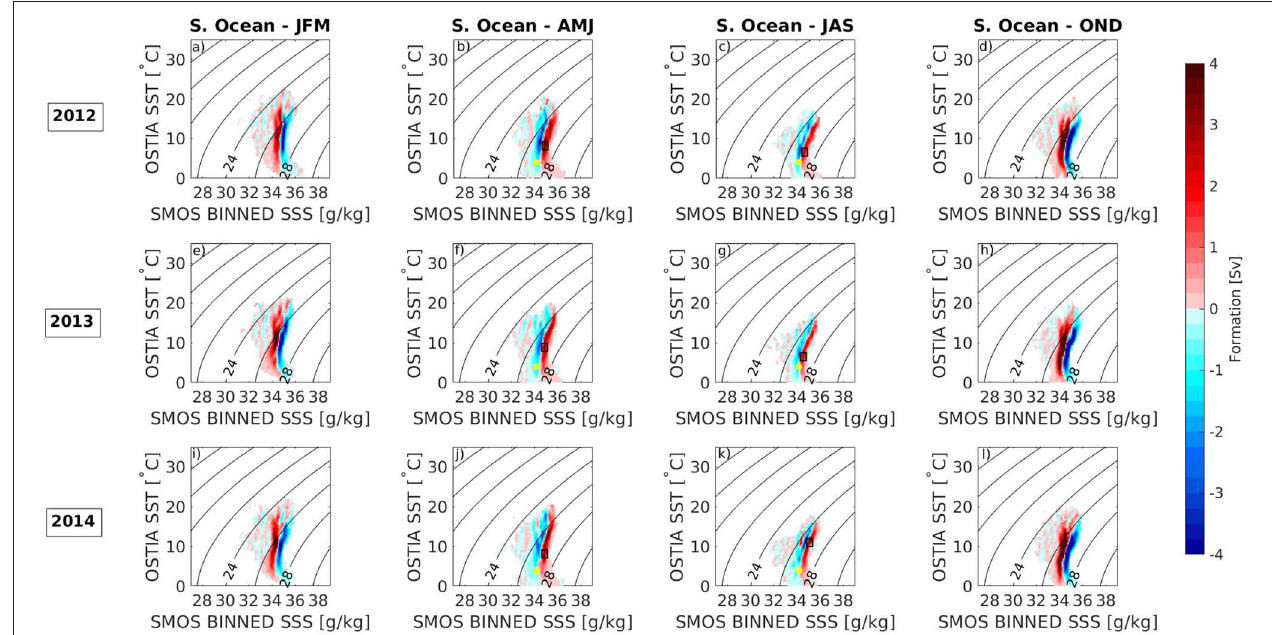
FIGURE 8 | Same as Figure 6 but for the Southern Ocean and the yellow dots in the two centre columns (AMJ and JAS) show the literature properties of the SAMW (McCartney, 1977, 1982).